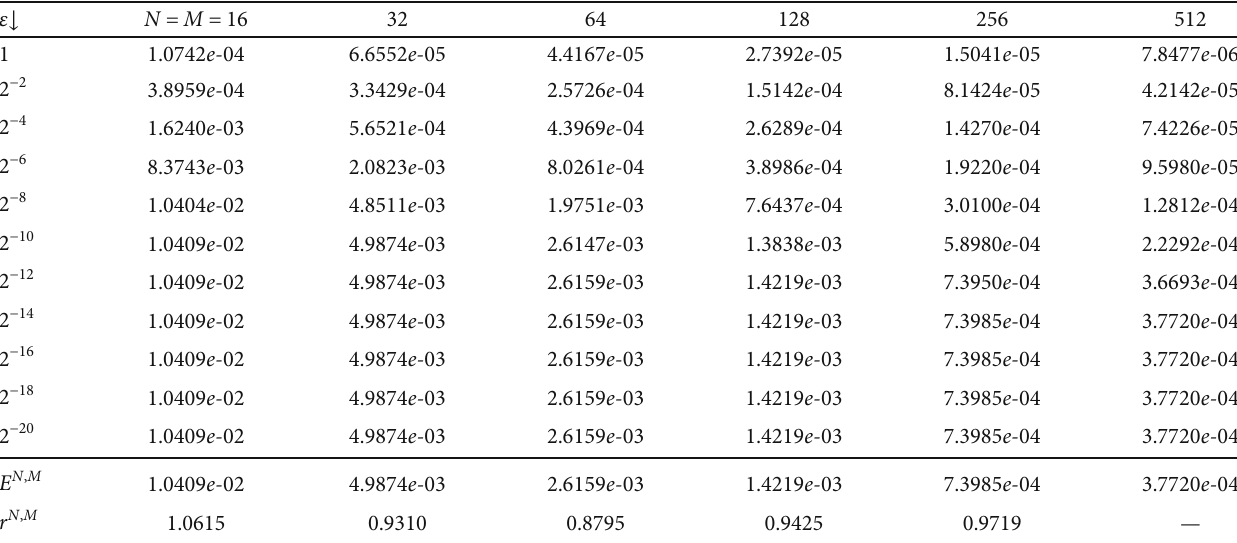
Table 1: Example 19, maximum absolute errors of the scheme.